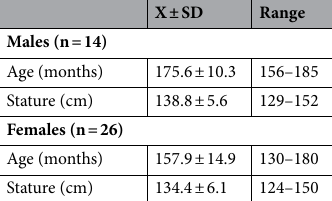
Table 2. Mean, standard deviations and range of age and stature at peak of growth in the